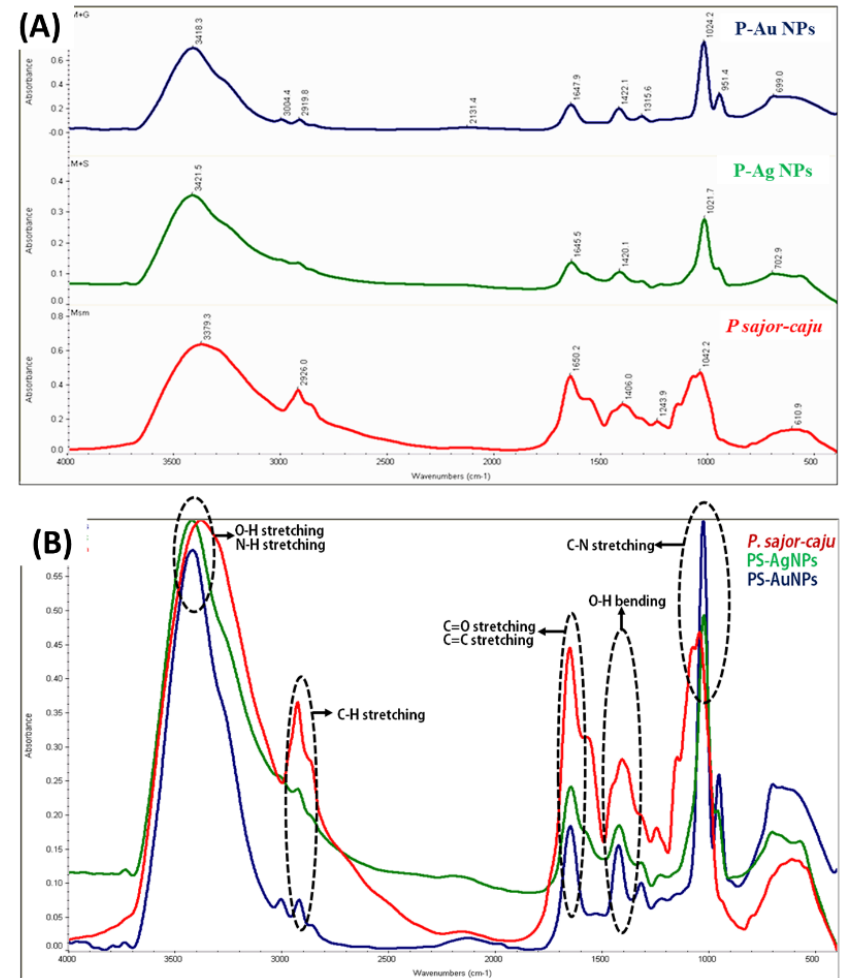
Figure 4. ( A ) FTIR absorption spectra of PS extract, Ag NPs and Au NPs., which confirm the capping of the phyto extract on the surface of the synthesized nanoparticles ( B ) FTIR overlay with stacking peaks of PS extract, Ag NPs and Au NPs with their respective functional groups.